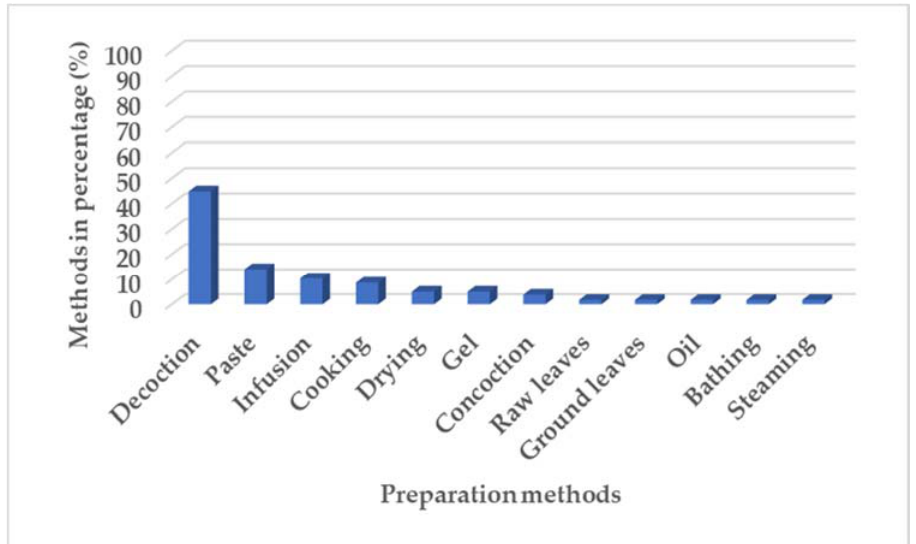
Figure 2. Distribution of plant parts in percentage (%) reported in survey.